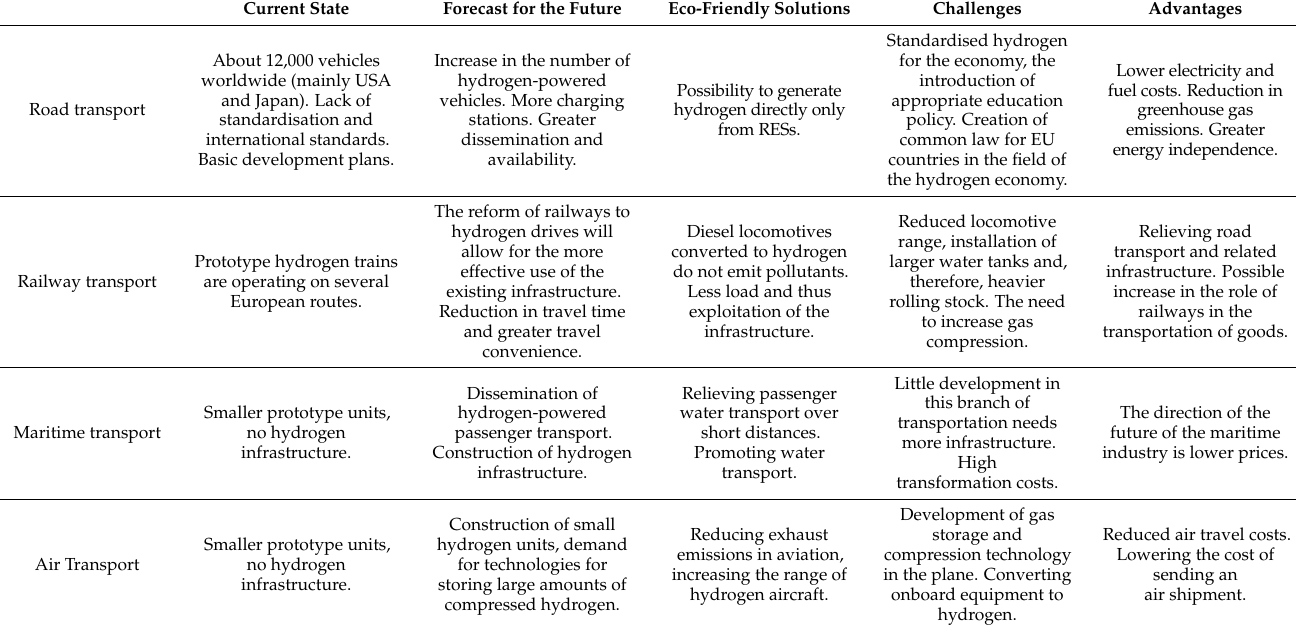
Table 1. Comparison of the use of hydrogen in various modes of